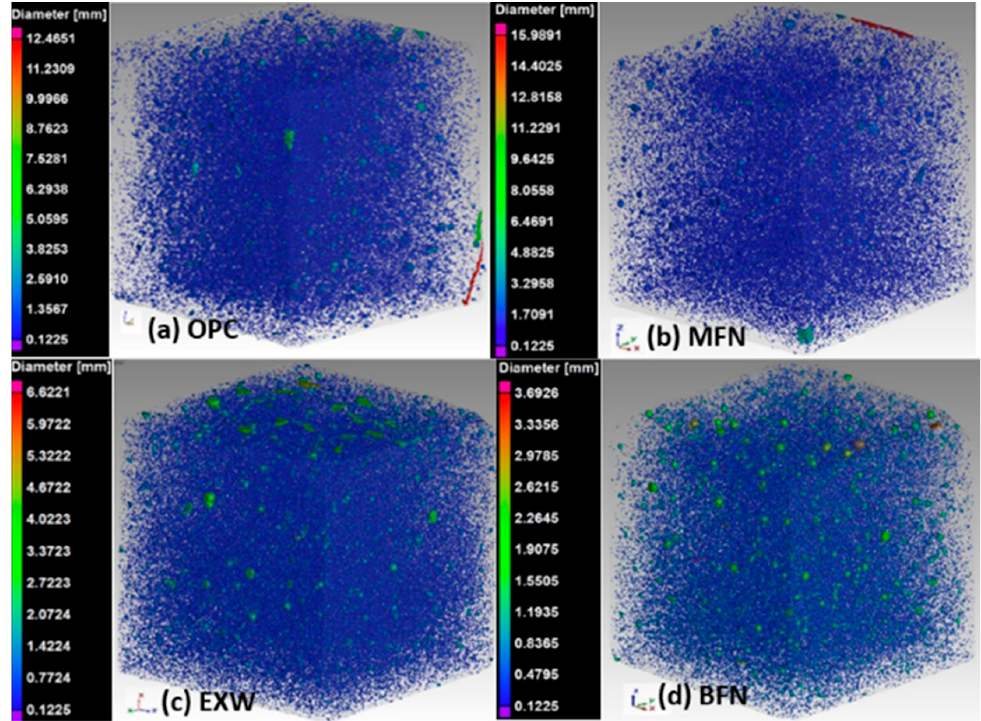
Figure 12. Micro-CT porosity analysis of specimens in 3D XYZ-plane. ( a ) OPC, ( b ) MFN, ( c ) EXW, ( d ) BFN.